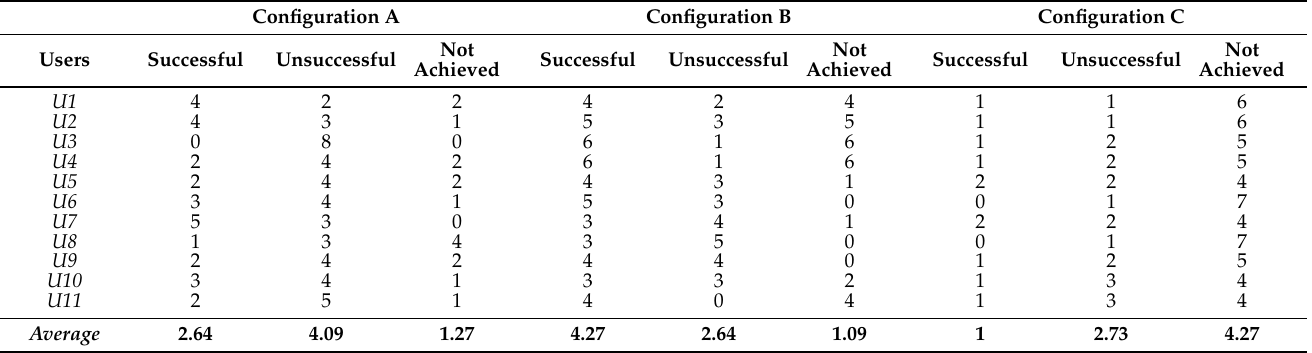
Table 2. Experimental results on successful, unsuccessful and unsuccessful attempts or not achieved. Configuration A Configuration